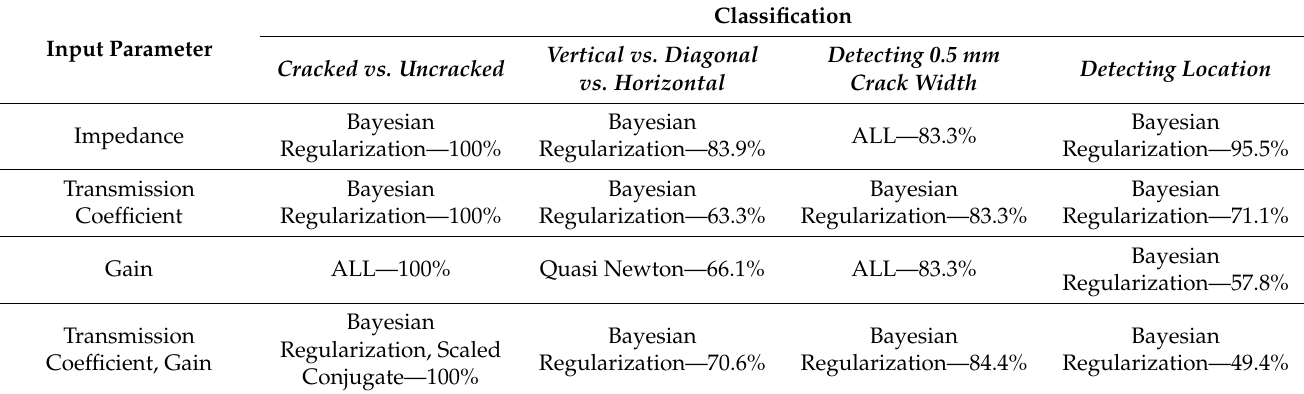
Table 8. Summary of the best classification performance parameters for all of the